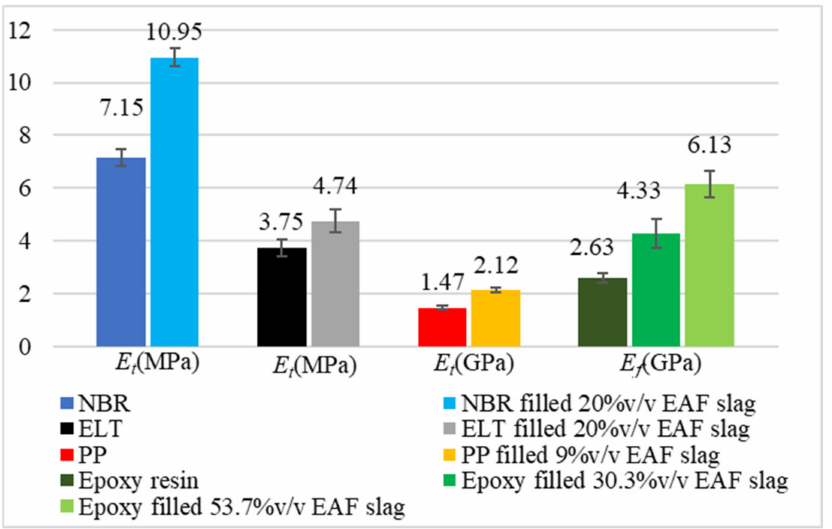
Figure 3. Influence of EAF slag as filler for NBR, ELT, PP, and epoxy resin matrix on elastic modulus.